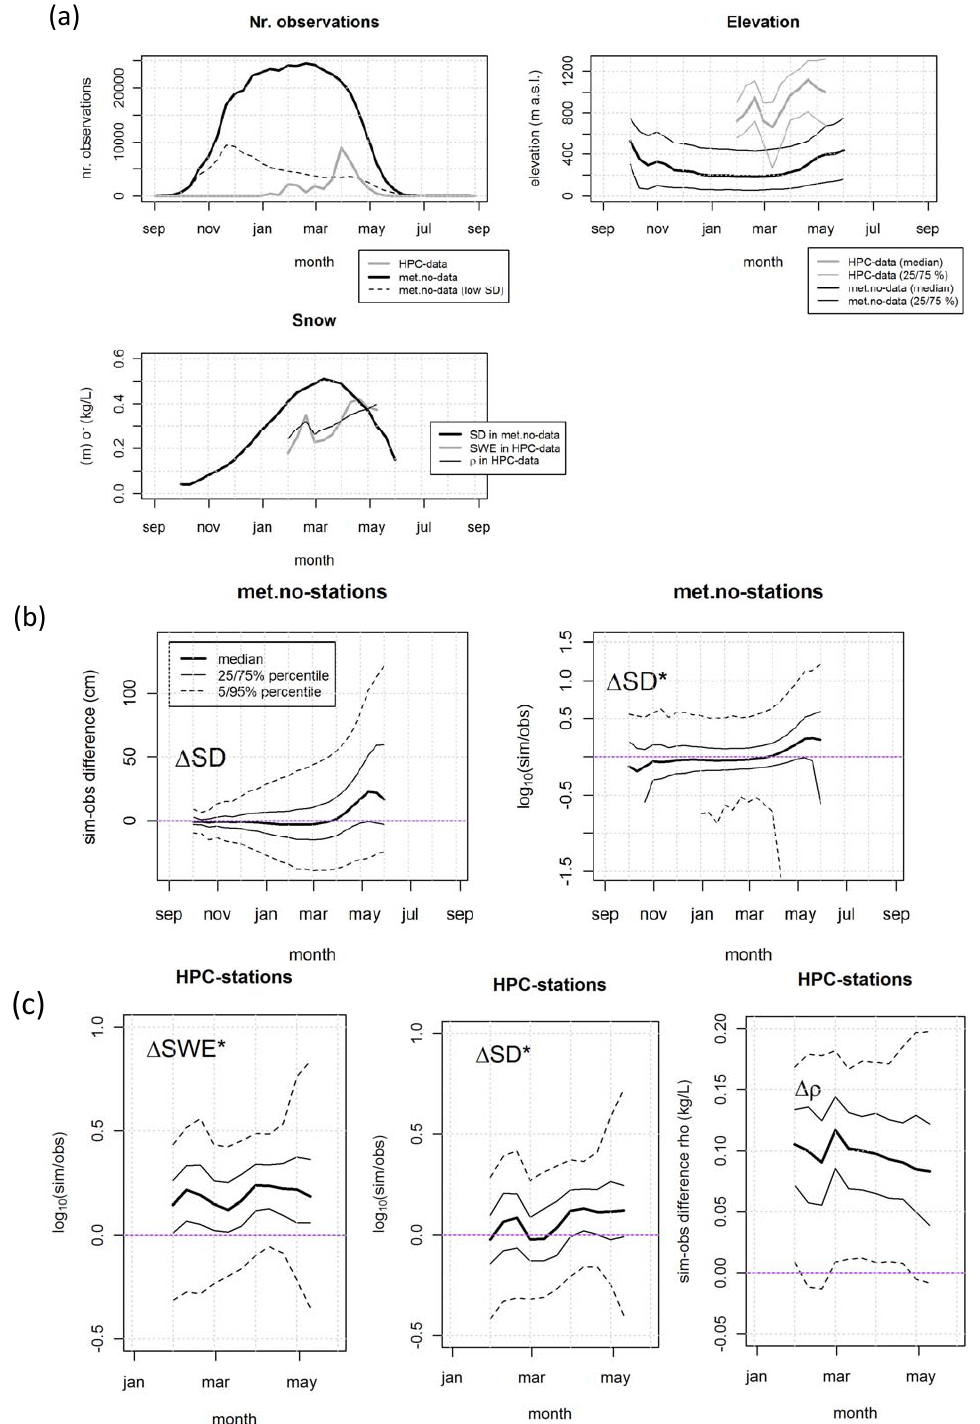
Figure 2. (a) Seasonal changes in the number of observations, in their median and 25/75 % percentile elevation, as well as in the observed median snow depth ( SD ), snow water equivalent ( SWE ) and bulk snow density ( ρ ) in the met.no- and HPC-data in 1957-2011. The dashed line denotes the “low SD” subset of the met.no-data where the simulated and/or observed snow depth ( SD ) is < 10 cm. (b) Seasonal changes in the median and 5, 25, 75 and 95 % percentiles of the distribution of the difference ( Δ SD ) and log 10 -transformed ratio ( Δ SD* ) between the simulated and observed SD in 1957-2011 in the met.no-data. (c) Same as (b), but now for the HPC-data, for log 10 -transformed ratio ( Δ SWE*, Δ SD* ) between the simulated and observed SWE and SD , as well as for the difference ( Δρ ) between the simulated and observed ρ . Only values based on at least 250 measurements (50 in HPC-data) per date are shown. Note that some of the 5 % percentile values in (b) are zero, and thus cannot be properly plotted on log-scale. The total number of observations in the figure is (b) ~392000 and (c) ~32000 .